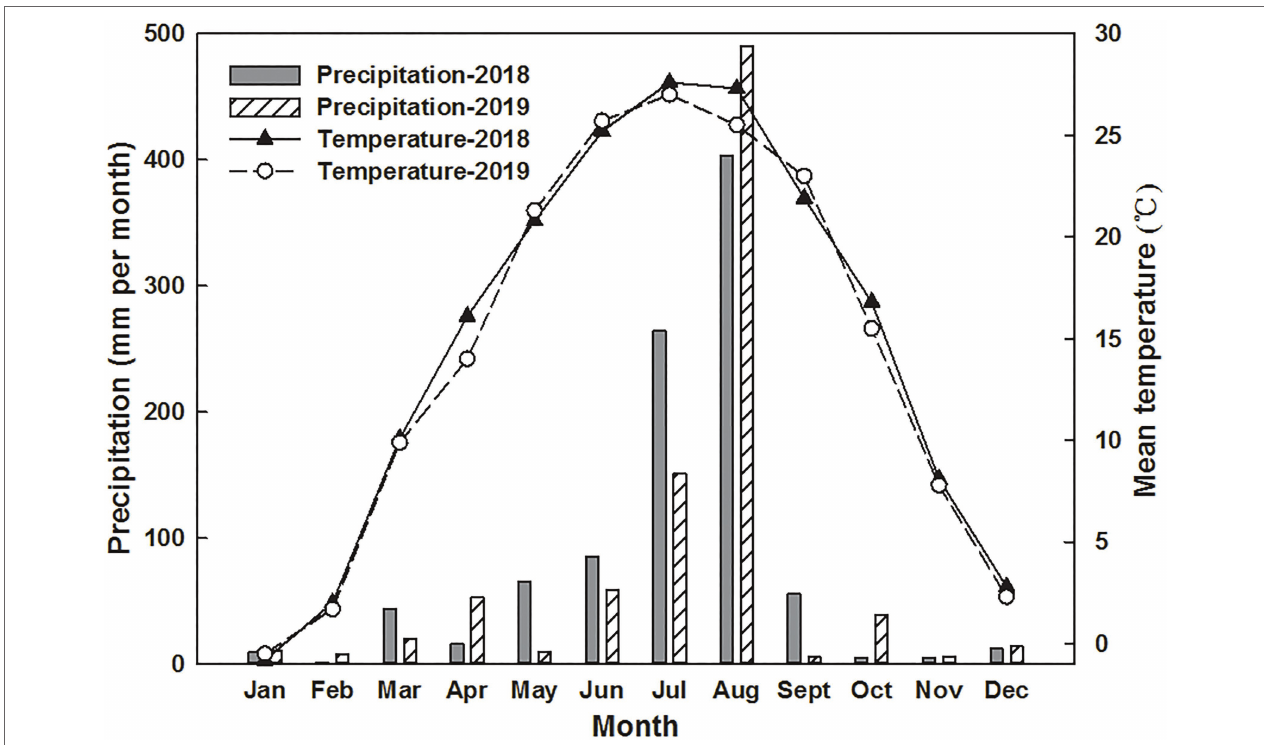
FIGURE 1 | Variations in precipitation and air